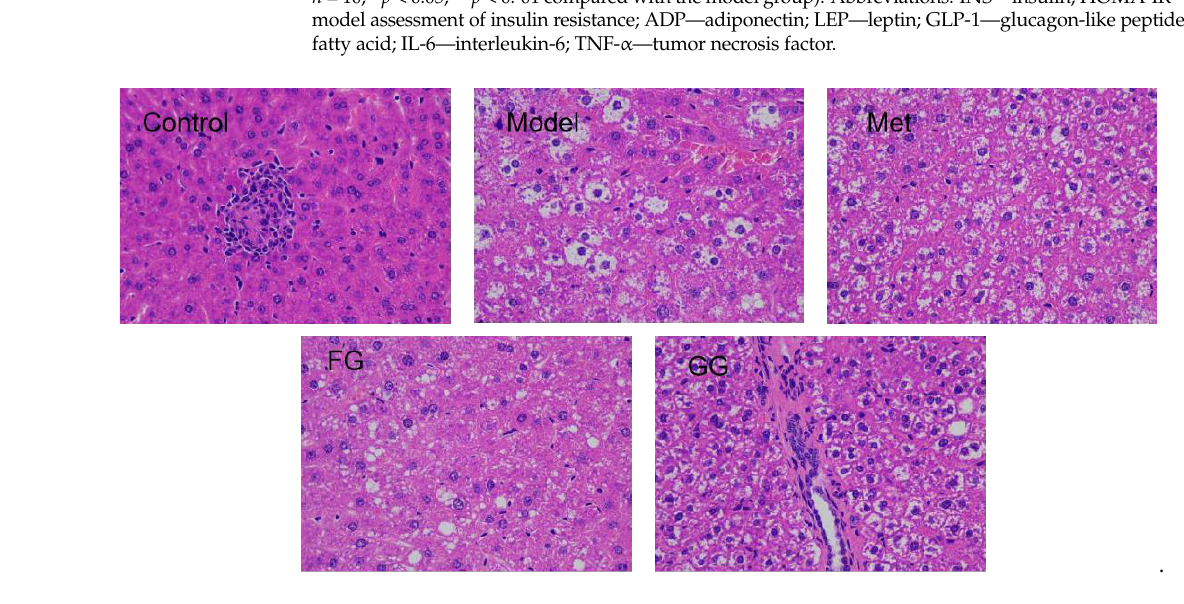
Figure 5. Metabolic profile analysis of the serum of the T2D model in db/db mice (( A ). NEG, PCA; ( B ). POS, PCA; ( C ). NEG, OPLS-DA; ( D ). POS, OPLS-DA). Figure 6. PRT analysis of the T2D model in db/db mice (( A ). NEG, PRT; ( B ). POS, PRT).